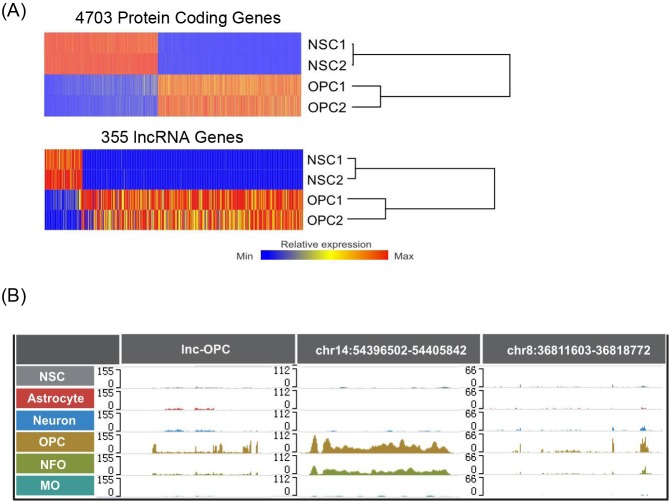
Global identification of lncRNAs regulated during oligodendrogenesis.(A) Heatmap depicting protein-coding genes and lncRNAs that are significantly differentially expressed (Fold change > 2 and FDR < 0.05) between NSCs and OPCs. Two biological replicates are represented in the plot. (B) Example RNA-Seq tracks for three lncRNAs that are enriched in the OPC lineage.